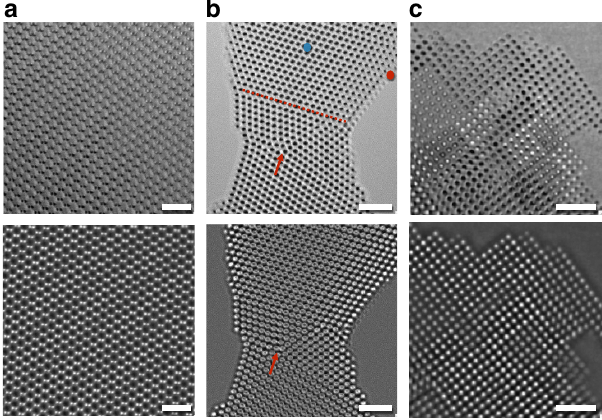
Figure 2 | In-line holograms acceleration voltage ¼ 300kV. Dose rates are given in Table 1. ( a ) Ge[110] and ( b ) Au[110] were reconstructed from focal series of 35 images with a focus step of 2nm and Cs ¼